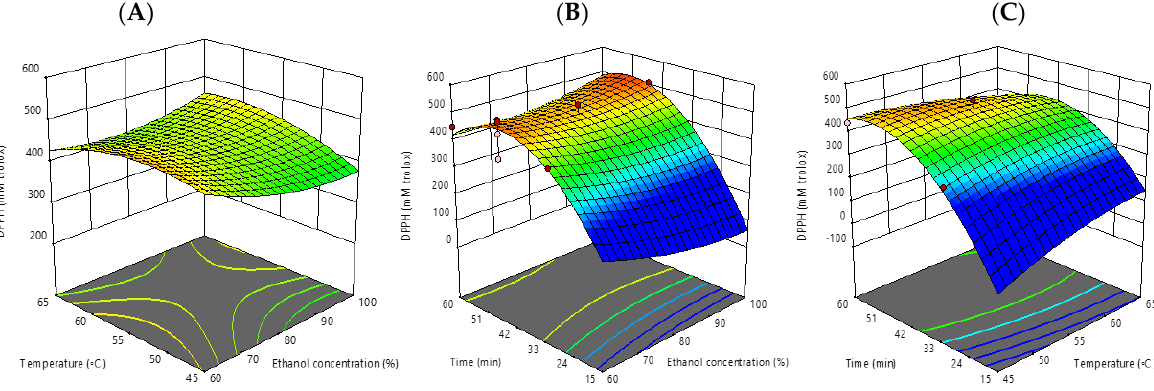
Figure 3. Response surface plots (3D) of antioxidant activity (DPPH assay) as a function of signifi- cant interaction between factors;( A ) temperature and ethanol concentration; ( B ) time and ethanol concentration; ( C ) time and temperature of CSP extract.